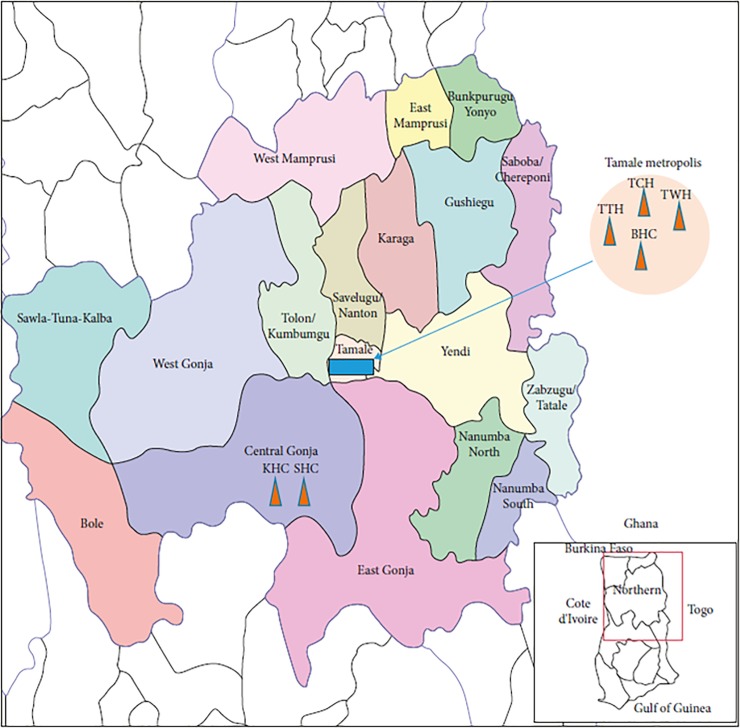
Map of Ghana showing the locations of the study sites (triangles in orange).The study sites are located in the Northern Region of Ghana. TTH: Tamale Teaching Hospital, TCH: Tamale Central Hospital, TWH: Tamale West Hospital, and BHC: Bilpella Health Centre are found in the Tamale Metropolis. While SHC: Sankpala Health Centre and KHC: Kosawgu Health Centre are found in the Central Gonja District (S1 File).